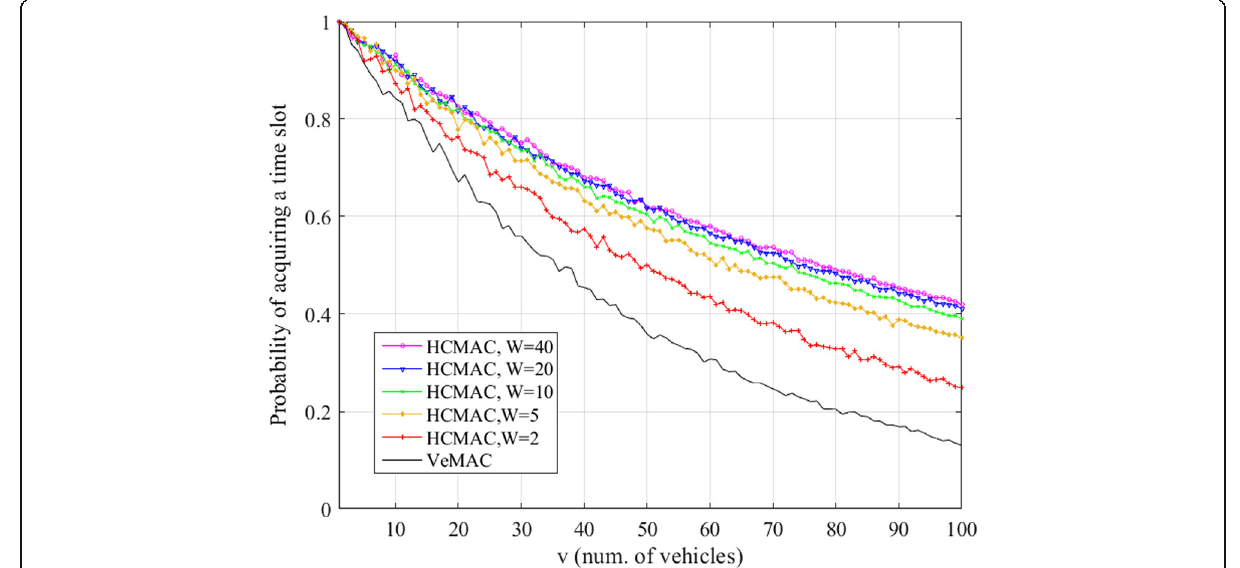
Fig. 14 The probability of acquiring a time slot (simulation results, S = 50, W = [2, 5, 10, 20, 40])